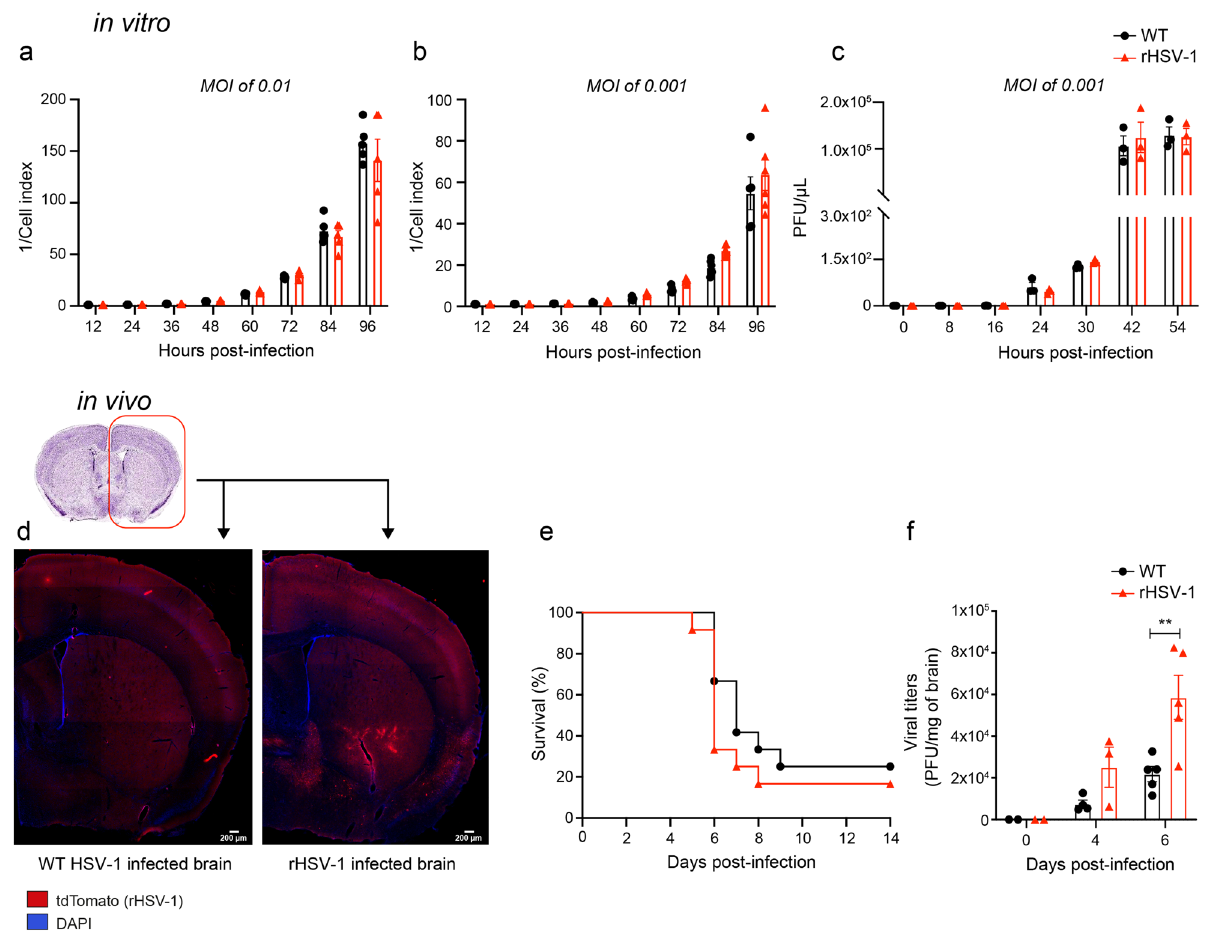
Figure 4. In vitro and in vivo replicative capacities of rHSV-1 ( a , b ) Replicative capacity of wild-type (WT) HSV-1 and recombinant HSV-1 (rHSV-1) were determined by real-time cell analysis (RTCA) for 96 h. Two different multiplicity of infection (MOI) [0.01 ( a ) and 0.001 ( b )] were used to infect Vero cells. Data are represented as 1/cell index, a dimensionless parameter that reflects changes of cellular morphology or growth rate (WT: black bars and circles, rHSV-1: red bars and triangles). ( c ) Replicative capacity of wild type (WT: HSV-1 strain H25) and recombinant HSV-1 (rHSV-1) virus at a MOI of 0.001, as determined by plaque assay. Vero cells were infected with both viral strains for 90 min at 37 °C in a 5% CO 2 atmosphere. The viral suspensions were removed, and cells were incubated with MEM plus 2% FBS. The cell culture supernatants were collected for 54 h. Results represent the means ± SEM for triplicate. ( d ) Representative fluorescent microscopy images of a WT HSV-1 (left) and rHSV-1-infected (red) (right) brain sections counterstained with DAPI (blue) on day 6 post-infection. tdTomato signal is localized in the bed nuclei of stria terminalis and medial preoptic area. ( e ) Survival curves of mice infected with WT HSV-1 (black line with circles) and rHSV-1 (red line and triangles). Survival rates were analyzed using a log-rank (Mantel-Cox) test. ( f ) Viral titers in brain homogenates were measured by a standard plaque assay on Vero cells on days 0, 4 and 6 post-infection. The results are reported as PFU per milligram of brain homogenates and represent the means ± SEM for 3 to 4 mice per group at each time point. Statistical analyses were performed using two-way ANOVA with Sidak’s multiple comparisons